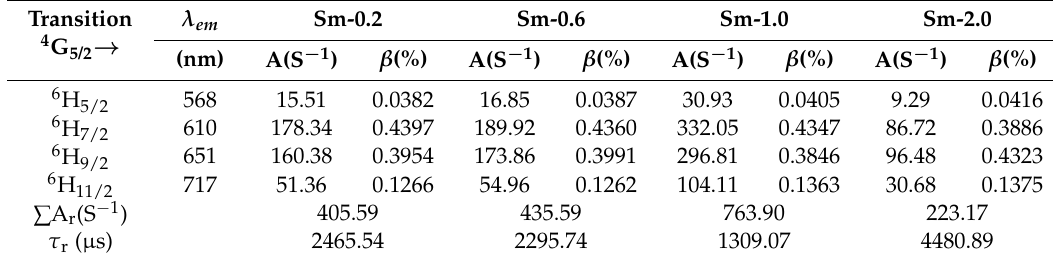
Table 3. The peak wavelength ( λ em ), radiative transition probability ( A r ), branching ratio ( β ), total radiative transition probability ( ∑ A r ), and radiative lifetime ( τ r